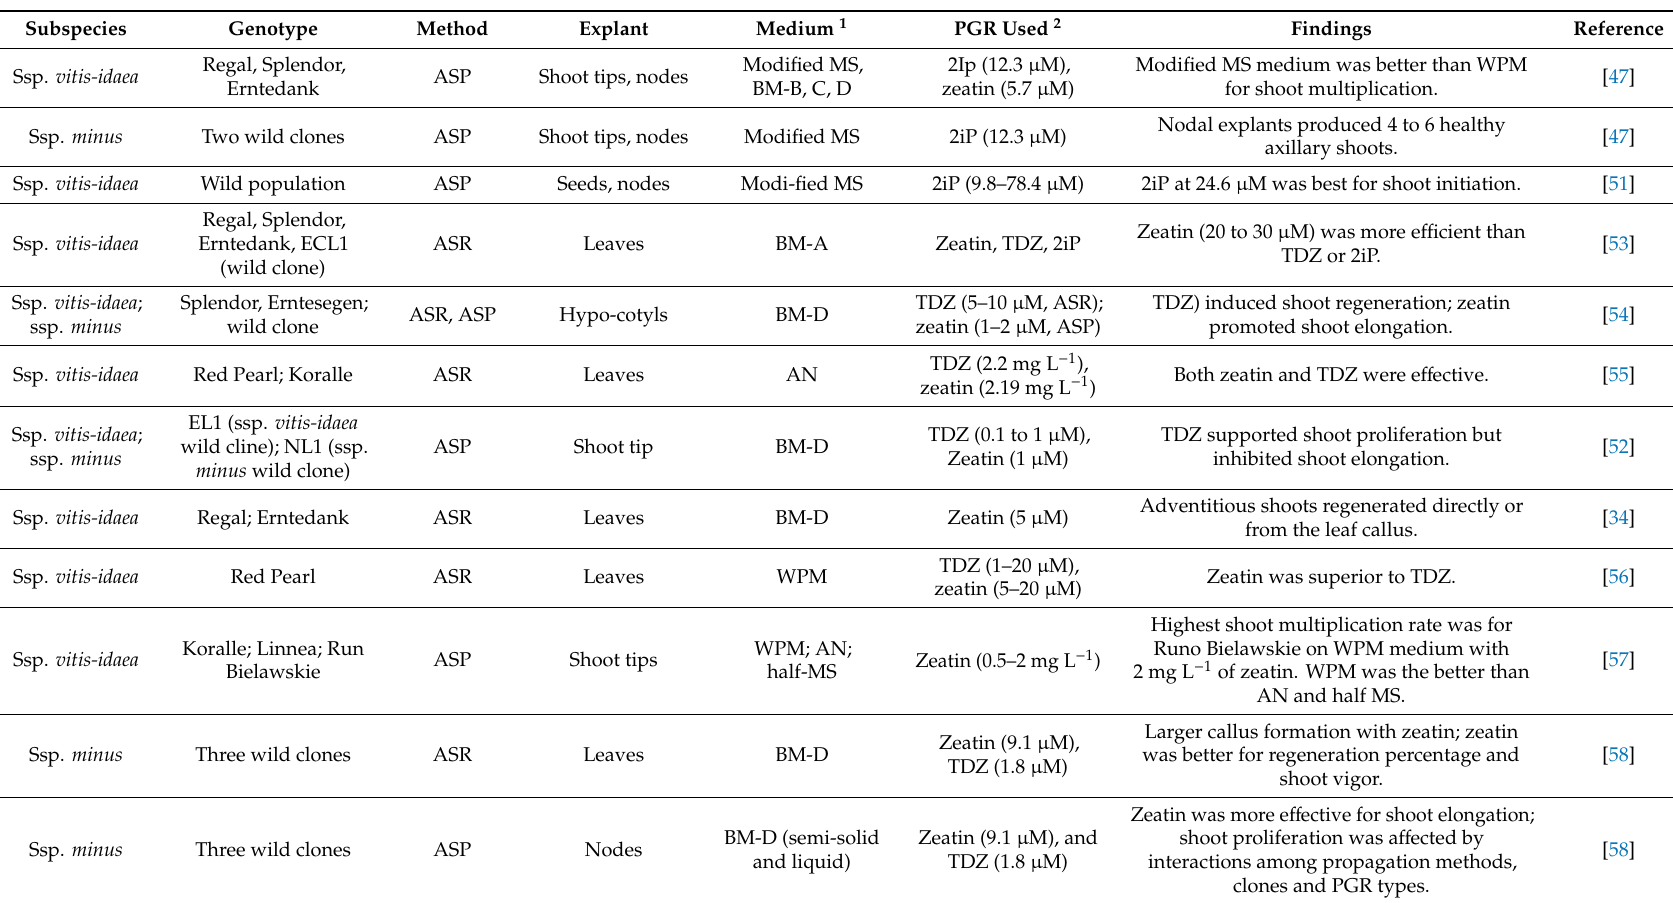
Table 2. Examples of axillary shoot proliferation (ASP) and adventitious shoot regeneration (ASR) in Vacinium vitis-idaea ssp. vitis-idaea and V. vitis-idaea ssp. minus